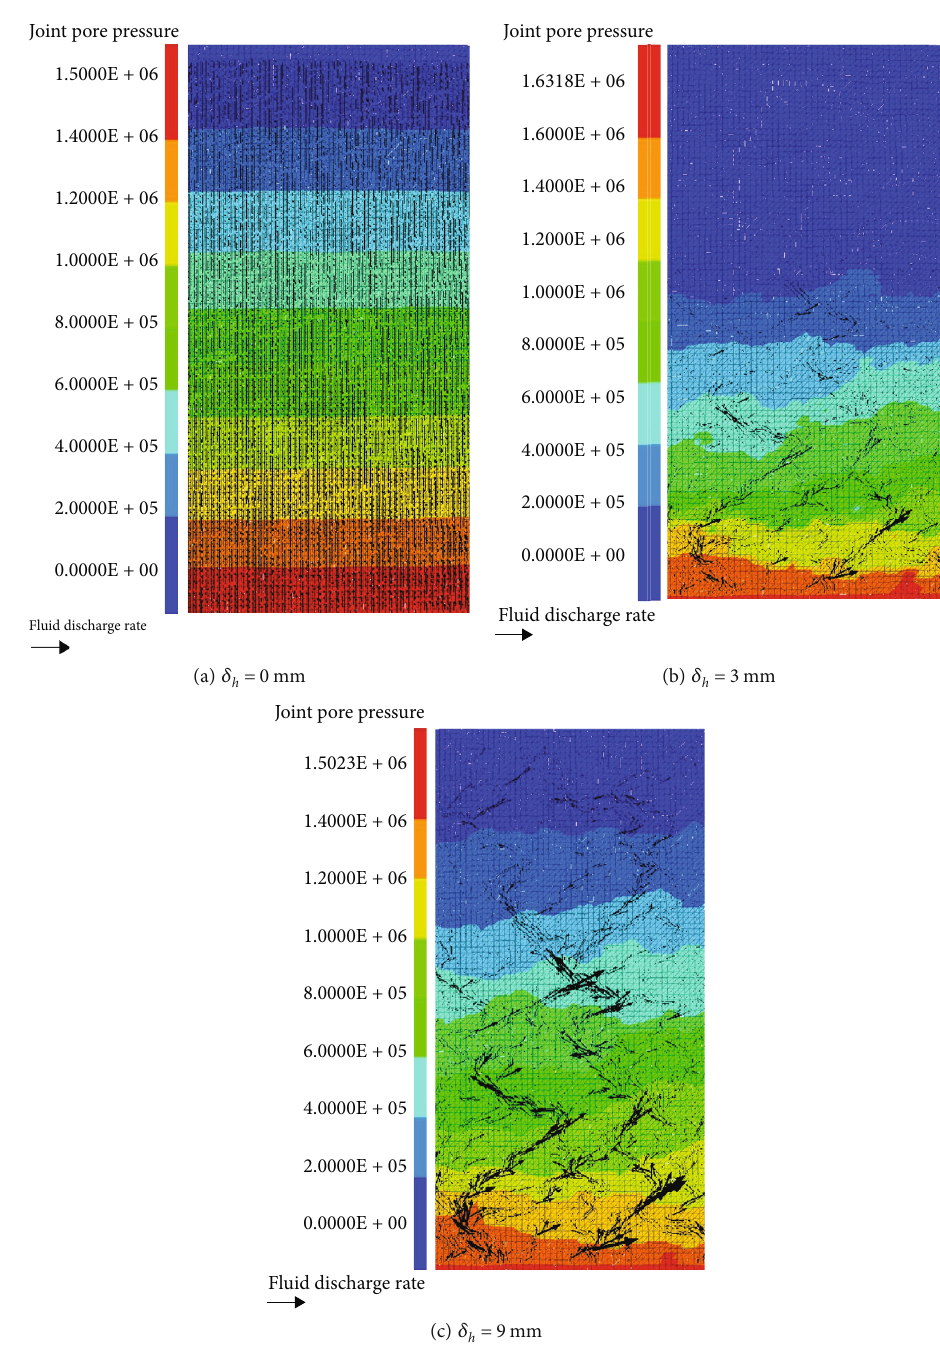
Figure 22: Evolution law of seepage pressure and seepage